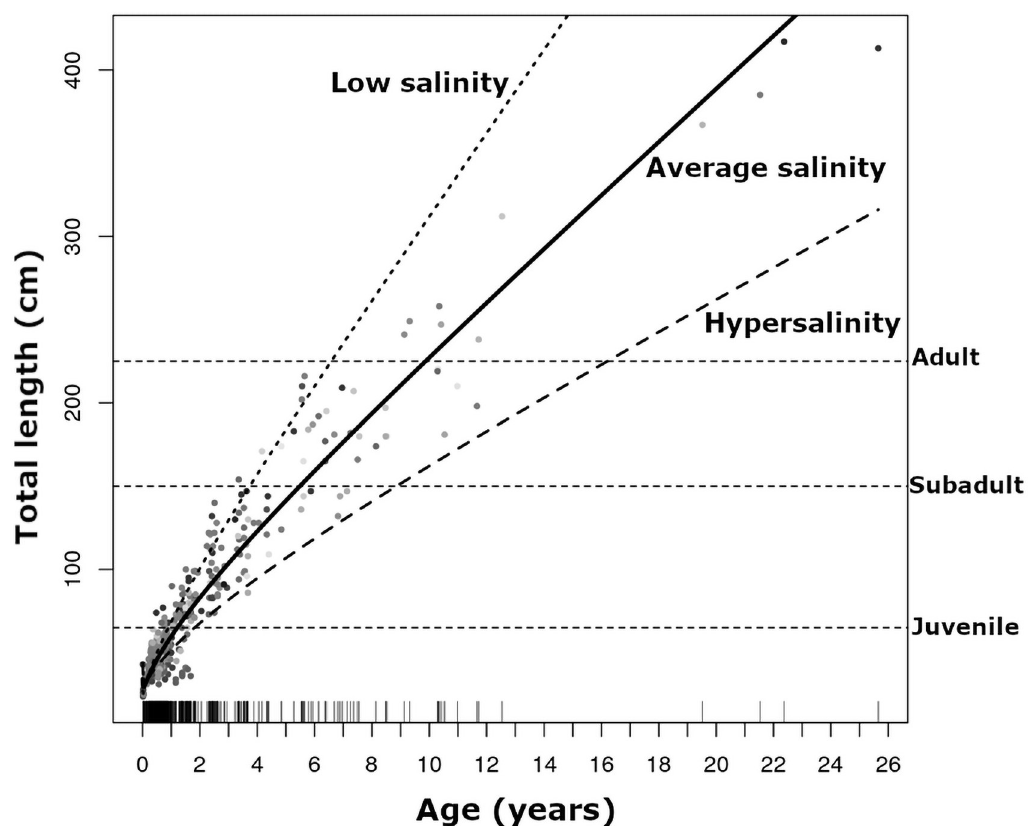
Fig 7. Growth curves developed for American crocodiles ( Crocodylus acutus ) recaptured between 1978–2015 in response to salinity conditions in South Florida. Horizontal dashed lines represent size